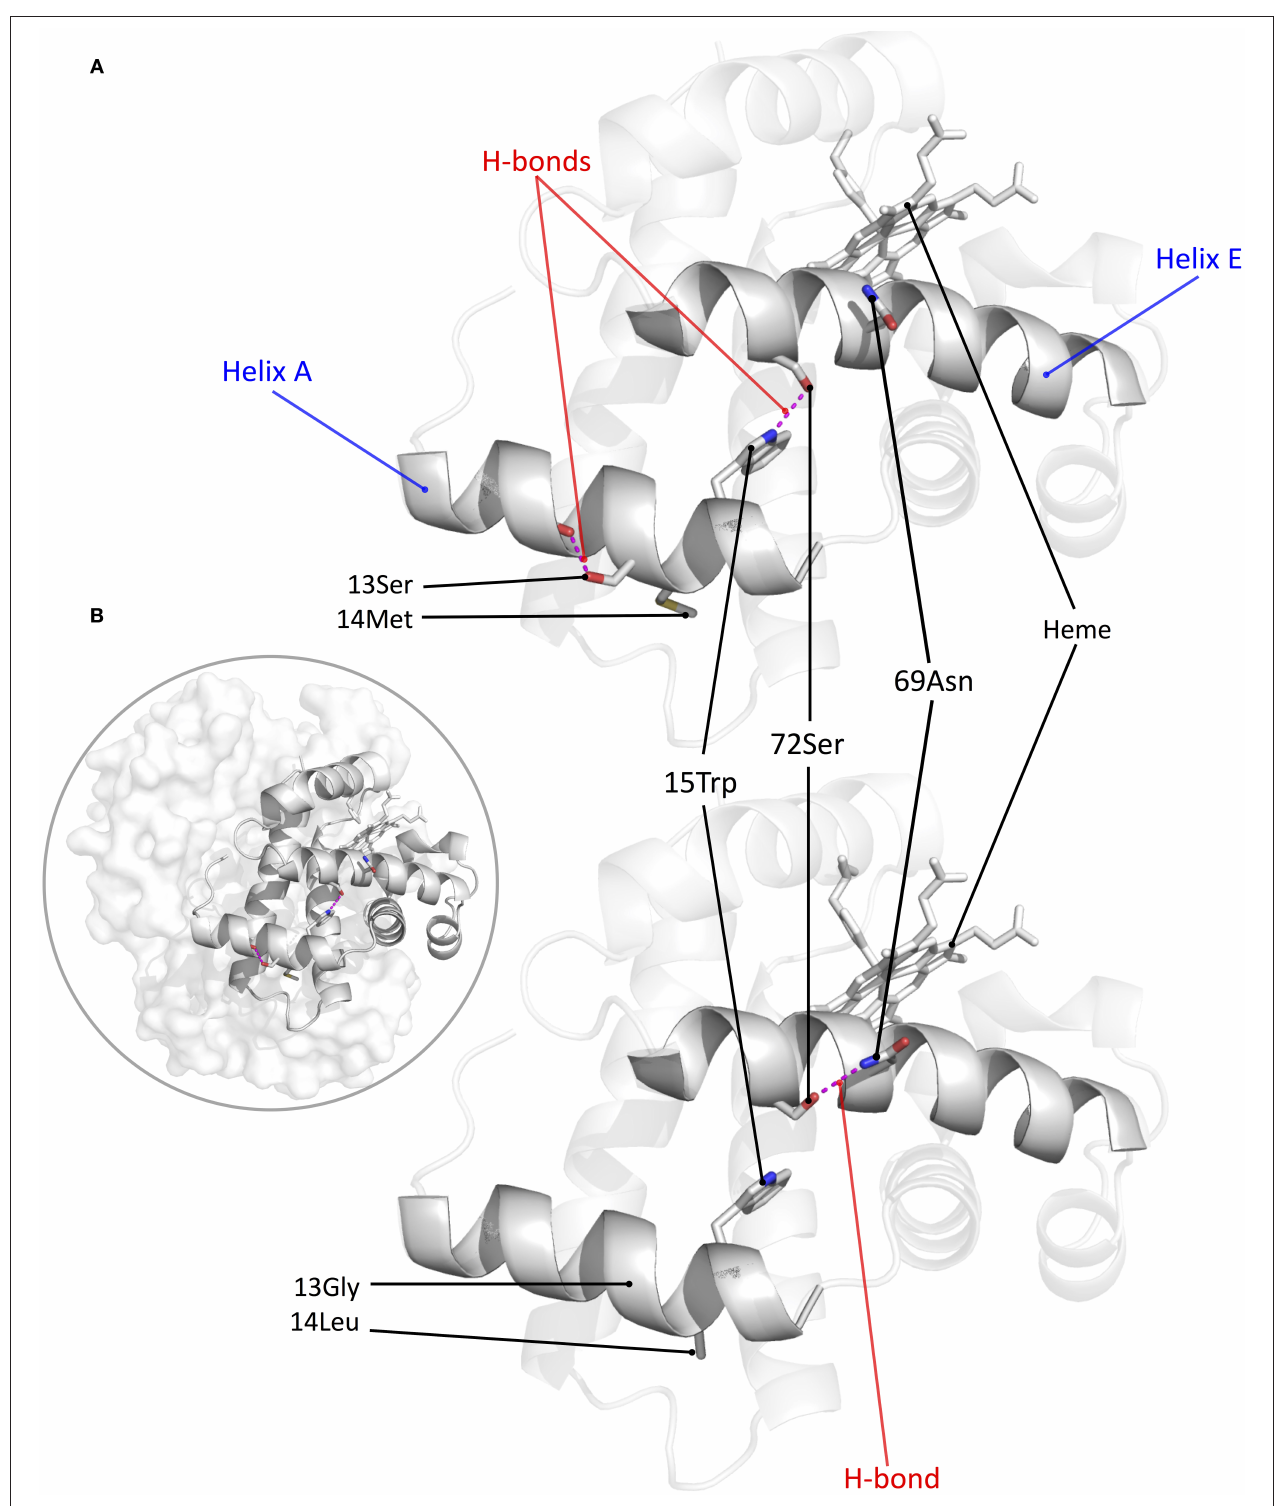
FIGURE 3 | Structural model of canine Hb showing the net effect of β -chain substitutions G13S and L14M. (A) β -chain of Tibetan mastiff/Tibetan wolf Hb, showing that the two substitutions result in the addition of two intra- and inter-helical hydrogen bonds (9-Ser: 13-Ser and 15-Trp: 72-Ser, respectively). (B) β -chain of domestic dog/gray wolf Hb, showing that 72-Ser forms an intrahelical hydrogen bond with 69-Asn instead of the interhelical bond with 15-Trp. Inset: structural model of tetrameric canine Hb with the β -chain subunit highlighted.